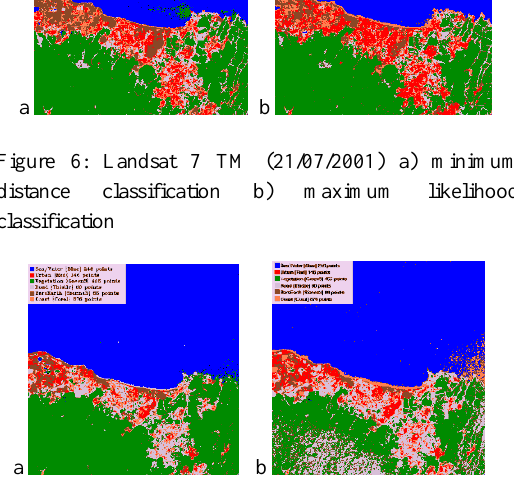
Figure 7: Landsat 5 TM (31/08/2007) a) minimum